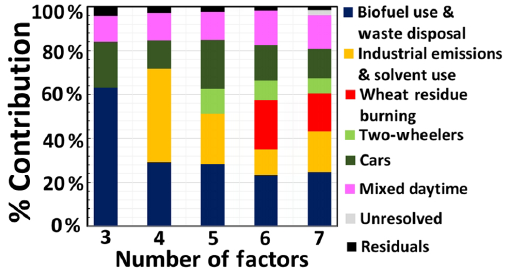
Figure 2. Percentage contribution assignment for various PMF fac- tor number solutions (3–7) to the corresponding VOC emission